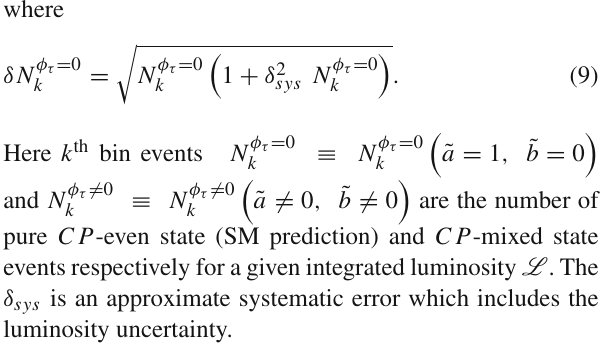
the one, two and three σ contours depict the respective mixing angles φ τ with SM like Yukawa coupling strength. Shaded interiors of the respective contours are however remain insensitive to the